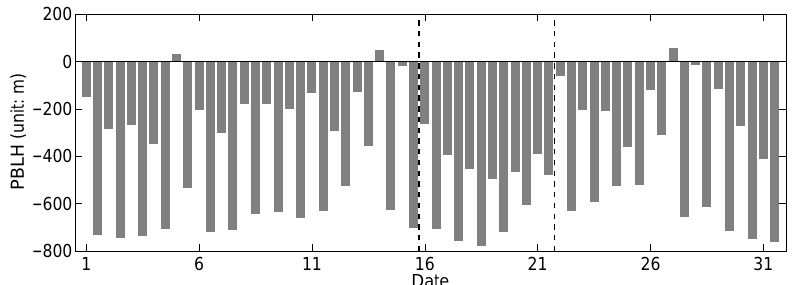
Figure 8. The variation of the area-mean anomalous height of the PBL in December 2016. The anomalies here are twice a day and calculated with respect to the December mean PBLH from 1981 to 2010.